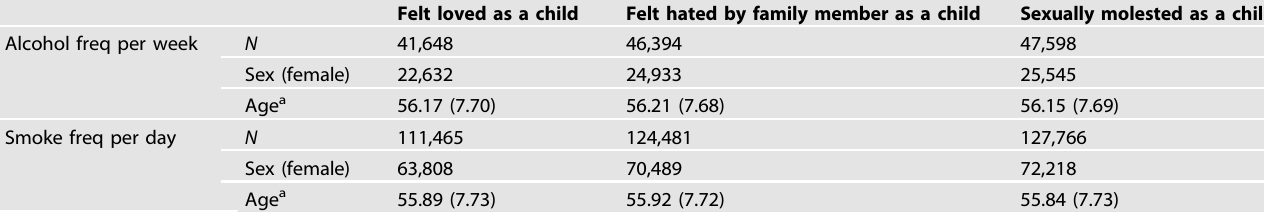
Table 1. Basic characteristics of study subjects from UK Biobank